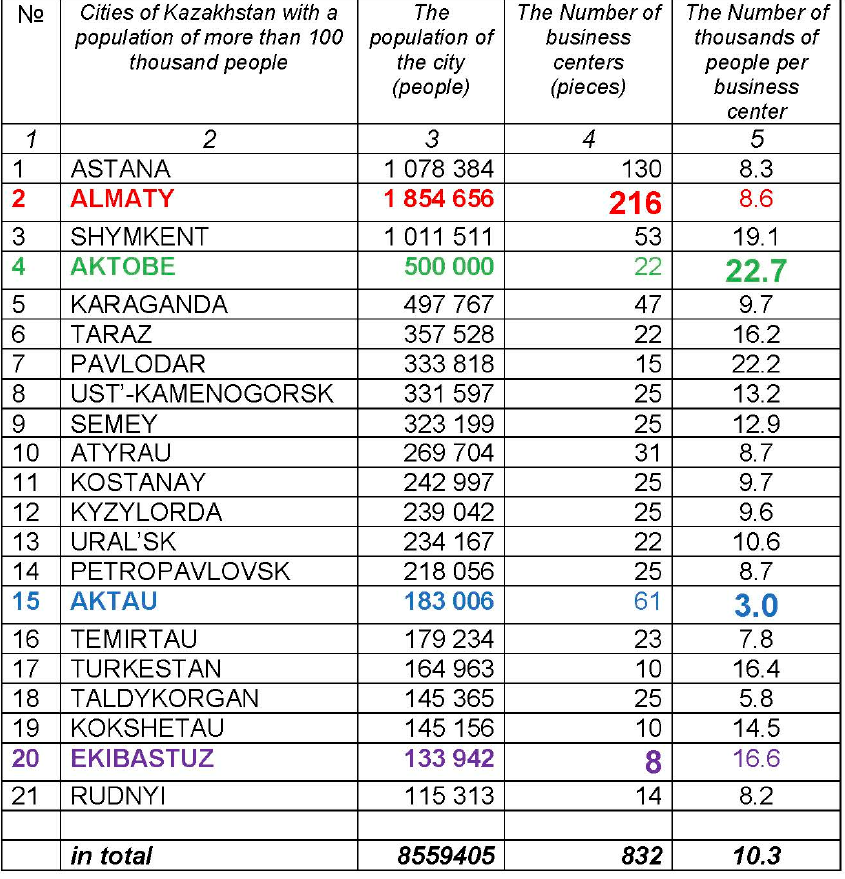
Figure 23. The saturation of Kazakhstan’s cities with business centers (number of population [158], number of business centers [https://2gis.kz/.../gallery/firm/; https://yandex.kz/maps/etc., accessed on 9 October 2022]).